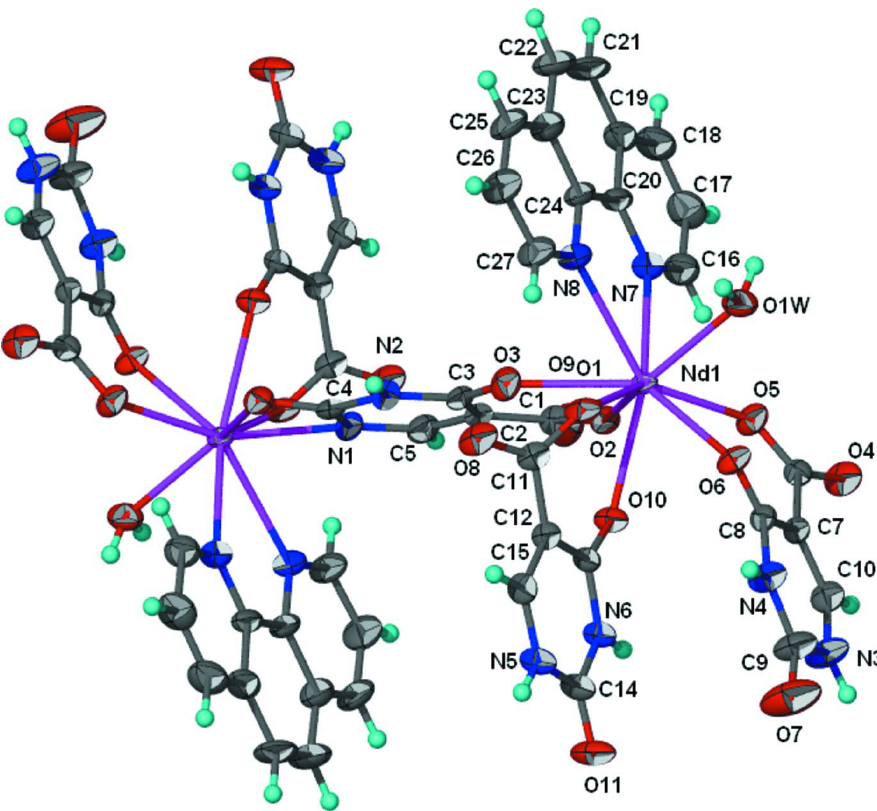
Figure 1 Displacement ellipsoid plot of Nd Unlabelled atoms are related to labelled atoms by the symmetry operation (1 - x , 1 - y , 1 - z ). Lattice water molecules have been omitted for clarity. Only one disorder component is